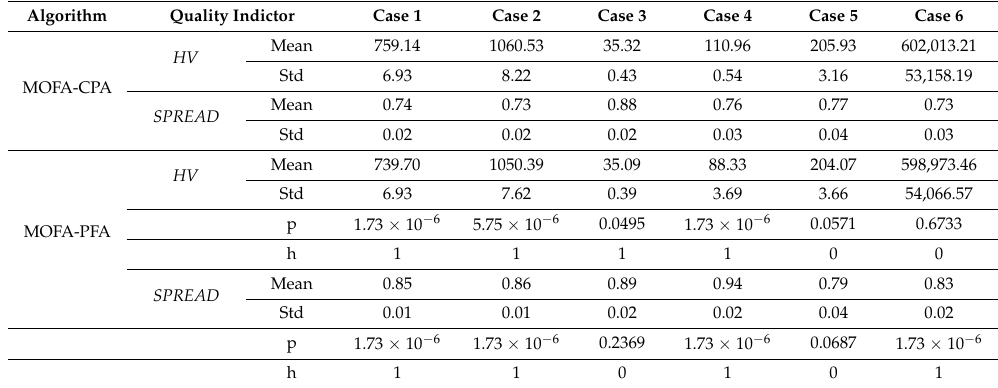
Table 10. The statistical results of HV and SPREAD of the two algorithms for Cases 1–6.